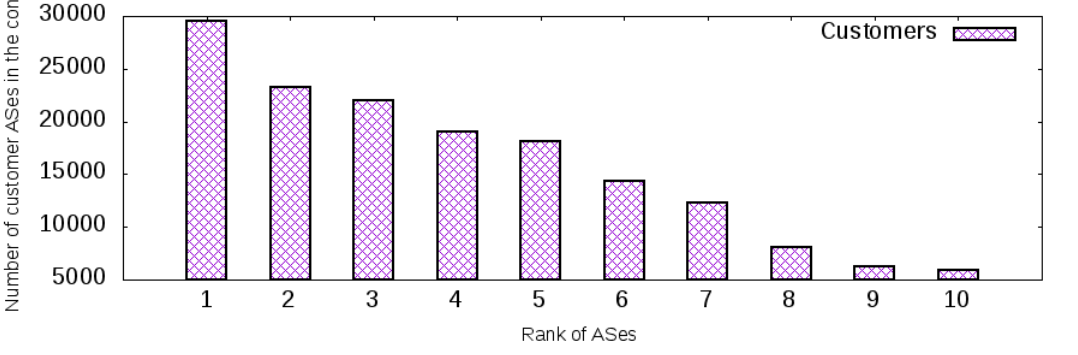
Figure 13. The potential number of customers affected by the proposed architecture deployed on the